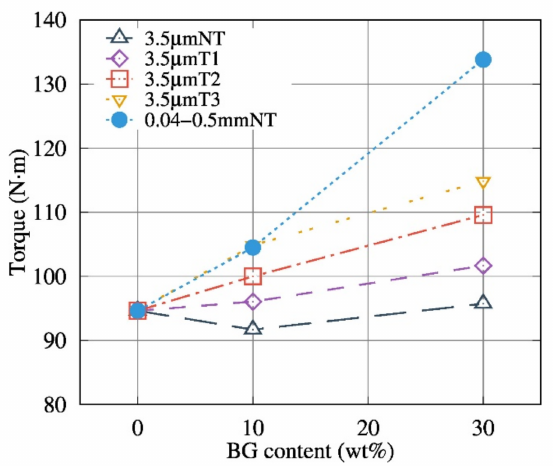
Figure 1. Torque of co-rotating twin screw as a function of BG content during extrusion process at 150 ◦ C with different thermal treatment and particle size as a function of BG